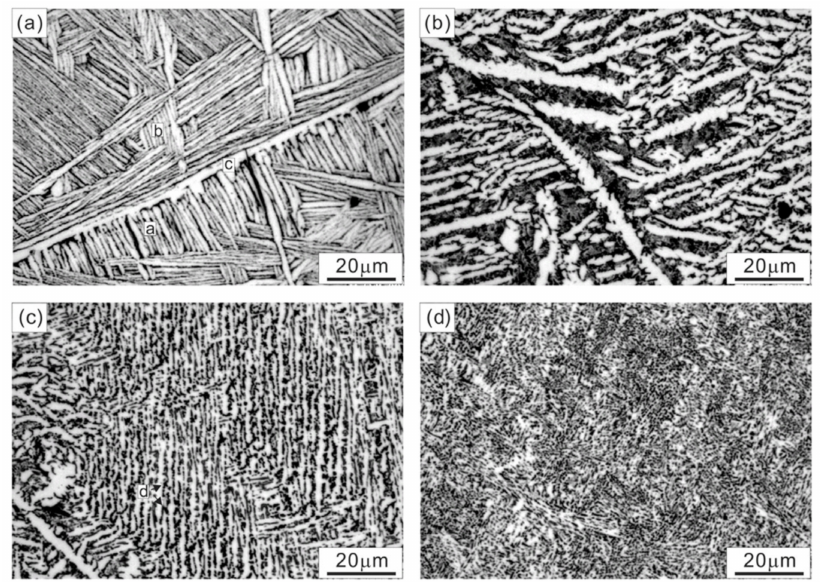
Figure 32. Microstructure of ( a ) Ti 7 Cu, ( b ) Ti 7 CuSn, ( c ) Ti 7 Cu 2.5 Sn, ( d ) Ti 7 Cu 5 Sn under OM